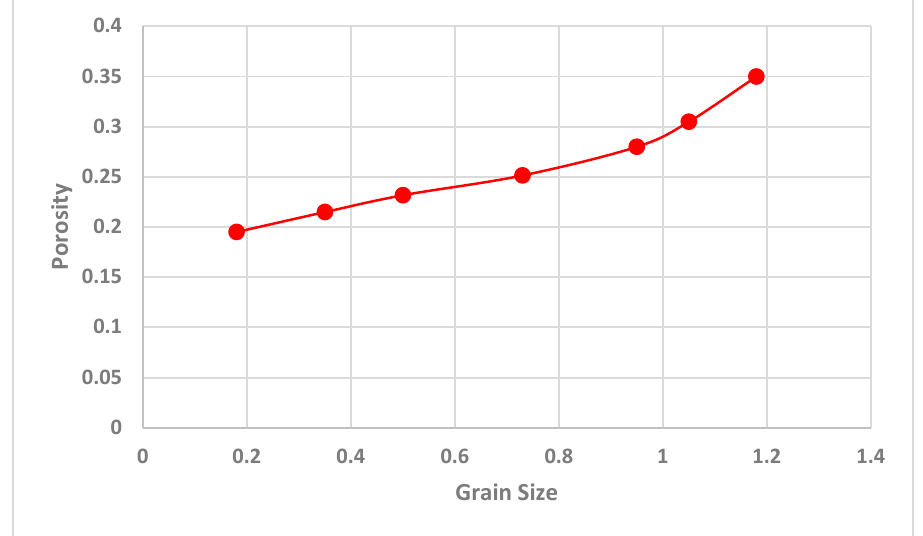
Figure 10. Relationship between the porosity of the samples and the grain size.